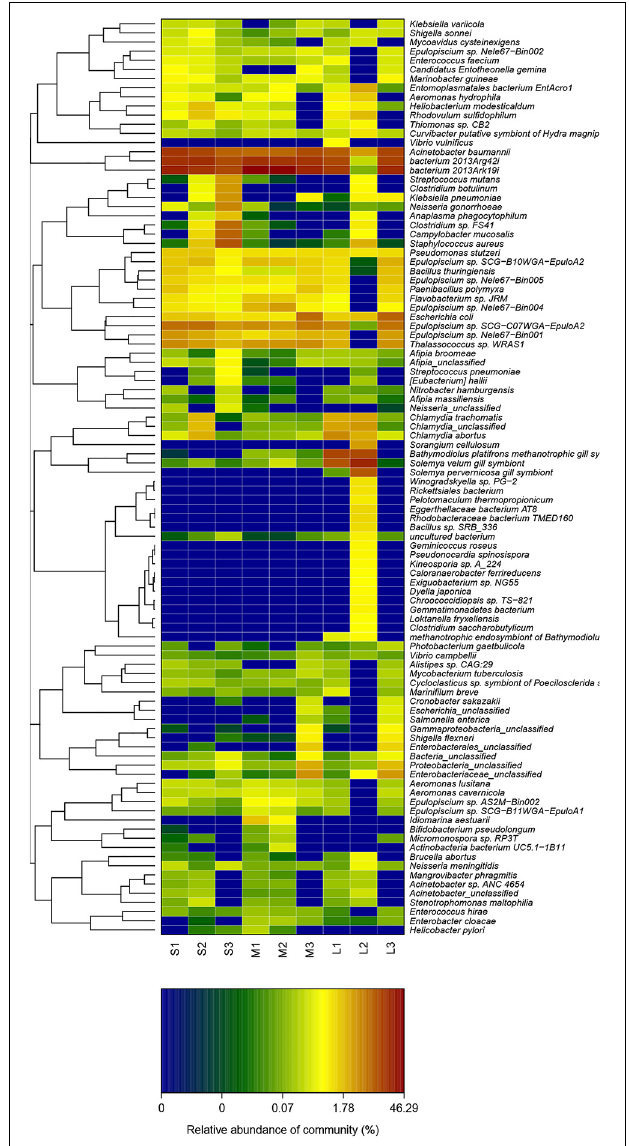
FIGURE 5 | Heat map of the cluster analysis of the top 50 species in terms of relative abundance among the three groups.